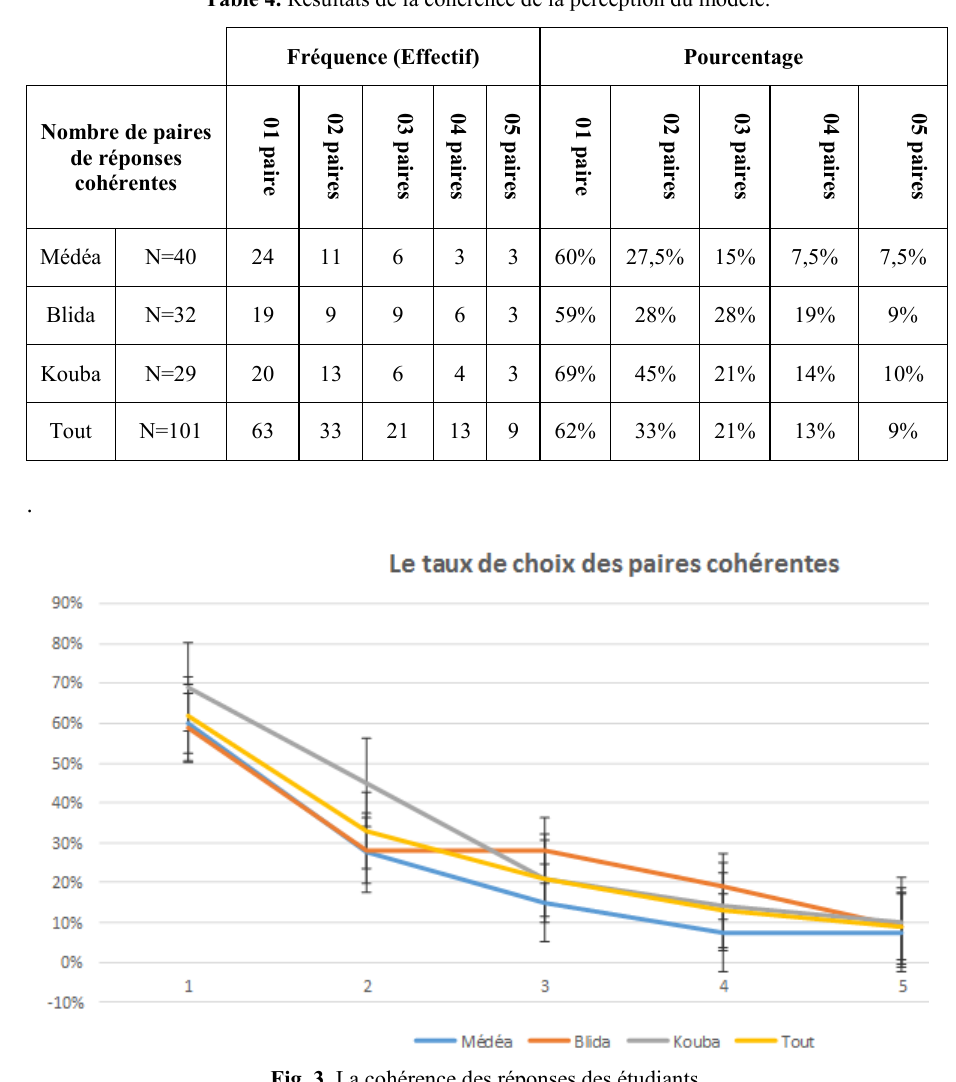
Fig. 3. La cohérence des réponses des